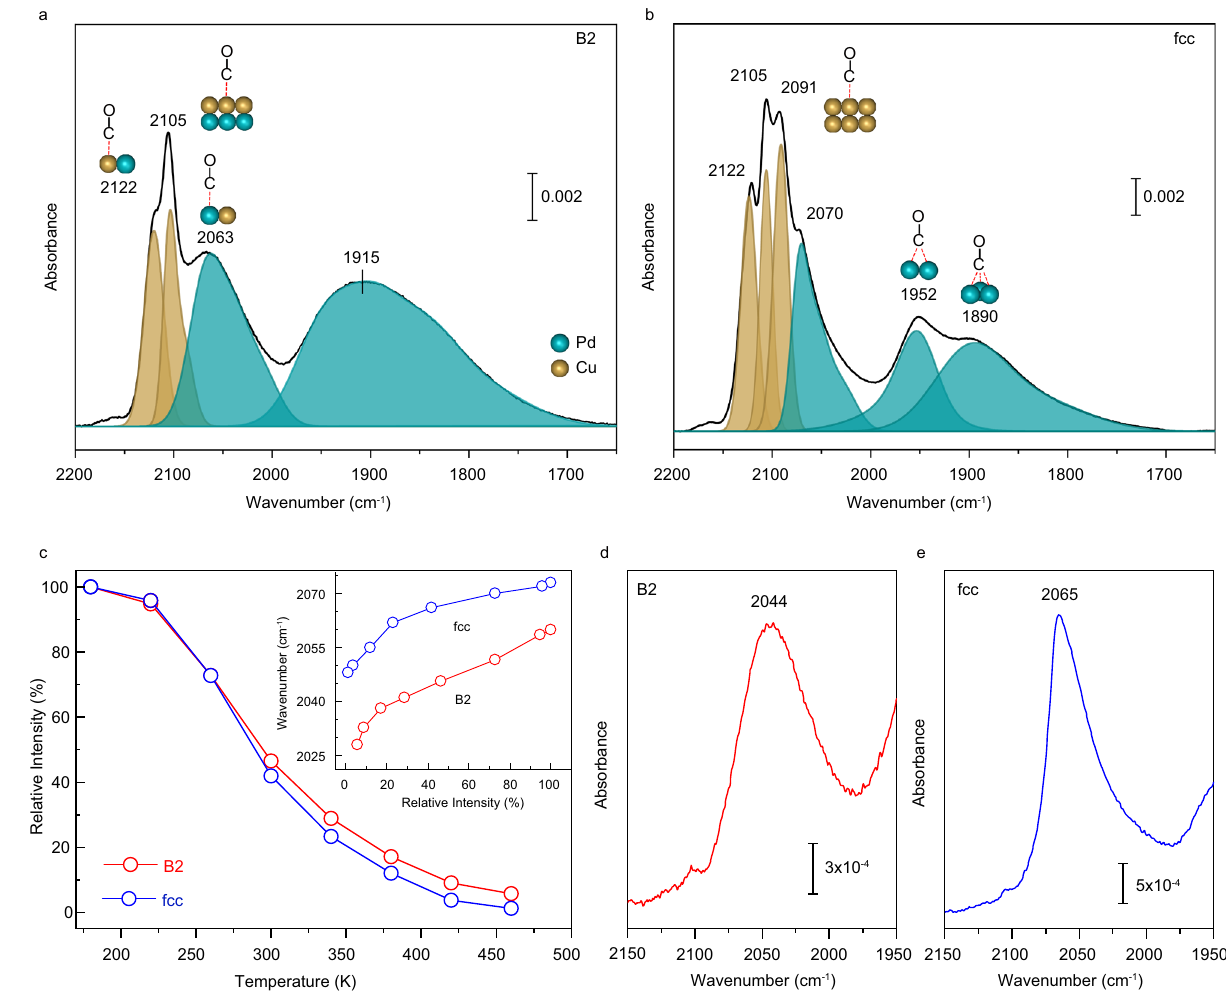
Fig. 4 | Geometric con fi gurationsand electronicinteractions ofsurface Pdand Cu atoms on the PdCu particles. a , b IR spectra of CO adsorptions on the B2 ( a ) andfcc( b )particles,recordedafterexposingthesamplestoCOat180K. c Intensity evolution of the on-top CO-Pd band, as a function of temperature. The spectra are acquiredafterCOadsorptiononthesampleat180Kandraisingthetemperatureto